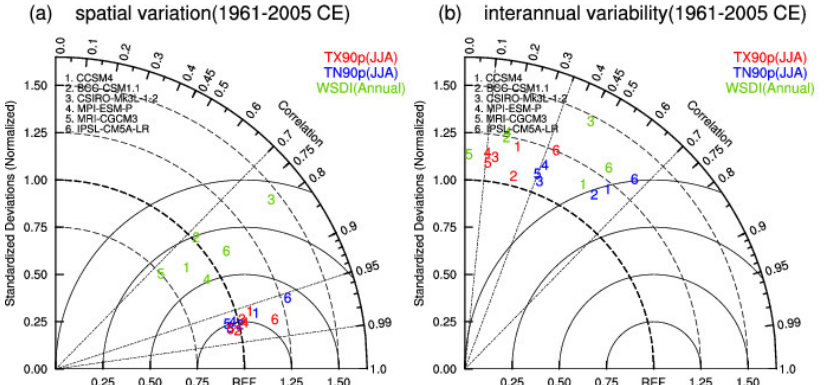
Figure 4. Taylor diagram of three indices during 1961–2005 CE over monsoonal China. ( a ) The performance of models in simulating spatial variation ( b ) The performance of models in simulating interannual variability. The radial coordinate gives the standard deviation normalized by the observation and angular axes represent correlations between simulated and observed datasets. Different numbers represent six models. Different color dots represent three indices.